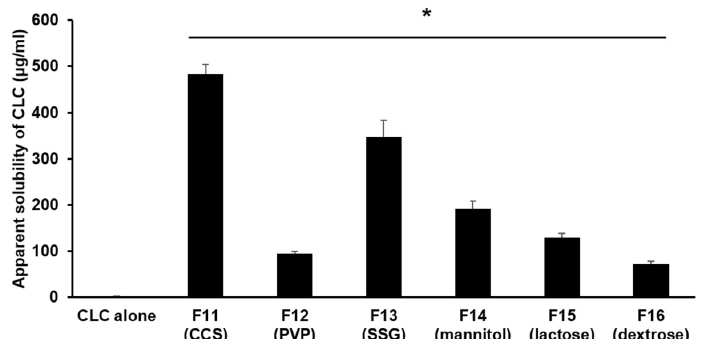
Figure 4. Apparent aqueous solubility of CLC incorporated in PC-based SD formulations containing different disintegrants (CCS, PVP, and SSG) and hydrophilic diluents (mannitol, lactose, and dextrose). The PC-based SD formulations tested were prepared with 150 mg PC, 100 mg CLC, 200 mg Neusilin ® US2, and 50 mg of each hydrophilic material (CCS, PVP, SSG, mannitol, lactose, and dextrose). CCS, PVP, and SSG are abbreviations for croscarmellose sodium, polyvinylpyrrolidone, and sodium starch glycolate, respectively. The values are mean ± SD ( n = 3). The asterisk indicates the statistical difference at P < 0.0001 in comparison to the aqueous solubility of CLC alone.